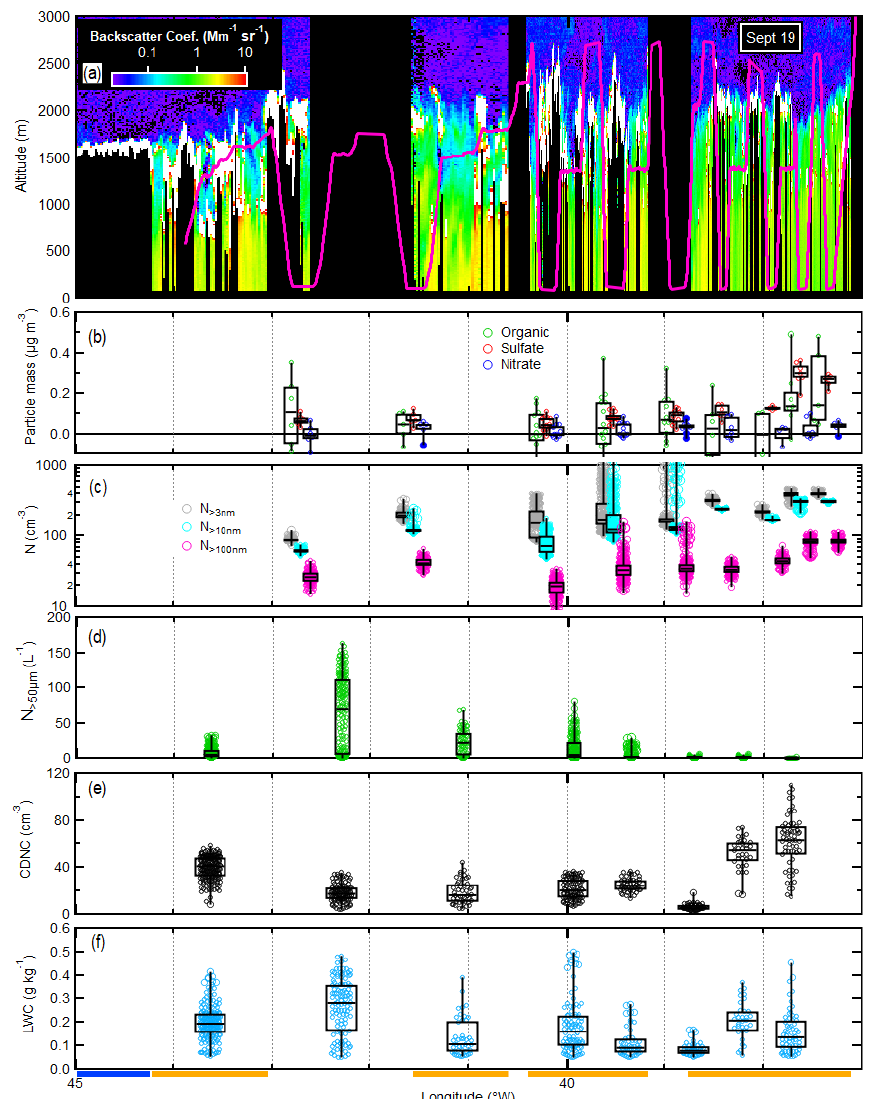
Figure 4. C130 particle measurements collected on the 19 September 2017 flight. The (a) C130 HSRL backscatter overlaid with C130 altitude (magenta), (b) non-refractory particle mass composition, and (c) particle concentrations ( N ) for particles > 3nm, > 10, and > 100nm in diameter. In-cloud (d) precipitation from the CIP (diameter >50µm) and (e) CDNC (diameter range of 2–50µm) and (f) LWC from the CDP are shown with box plots for each in-cloud leg. All measurements are presented as a function of longitude. The high-altitude HSRL back scattering measurements were made immediately before the surface measurements along almost the same horizontal flight track but in reverse (Fig. 1g–j). Any detours made at high latitude from the horizontal surface flight path were excluded from the HSRL swath shown. Blue and orange lines, at the bottom of panel (f) , represent the approximate longitudes with closed-cell and open-cell clouds, respectively. Note that while negative particle mass measurements are not possible, they are included to prevent exclusion of the negative bias in the AMS